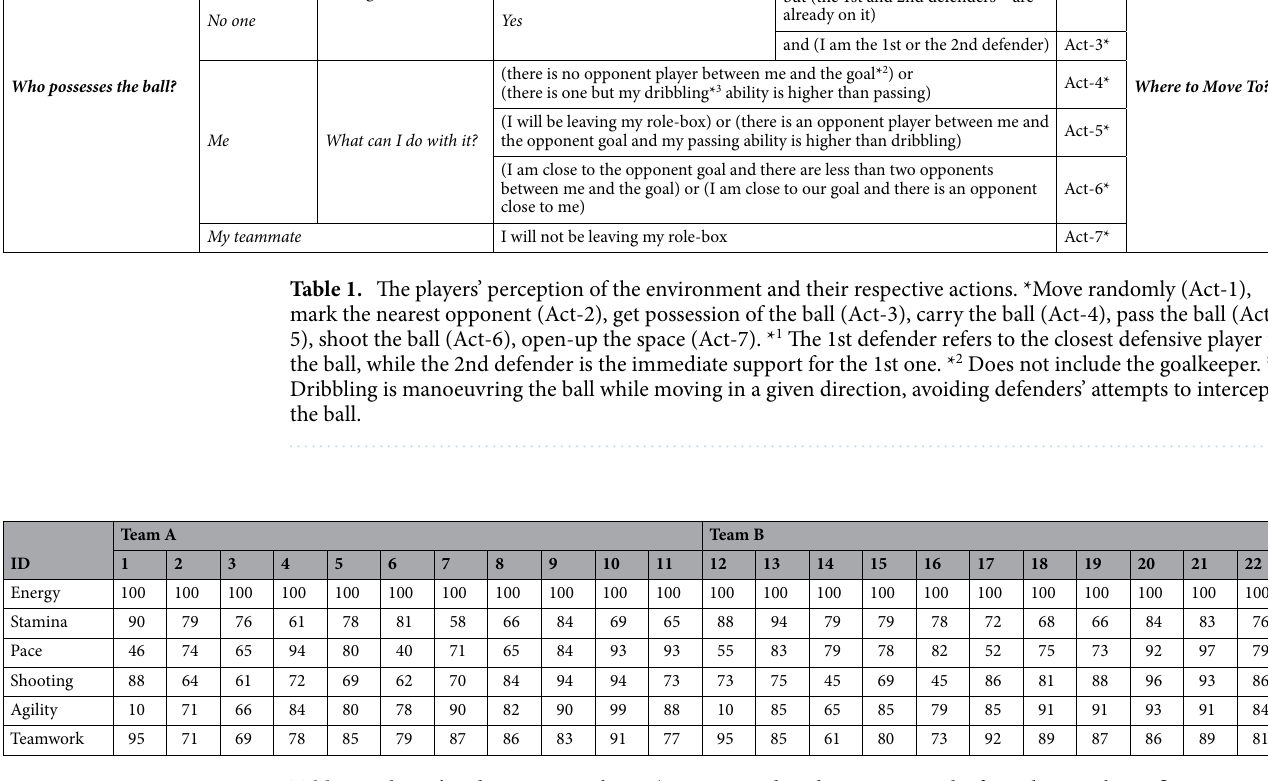
Table 2. Players’ endogenous attributes (Energy is reduced over time, and a few other attributes fluctuate as a function of